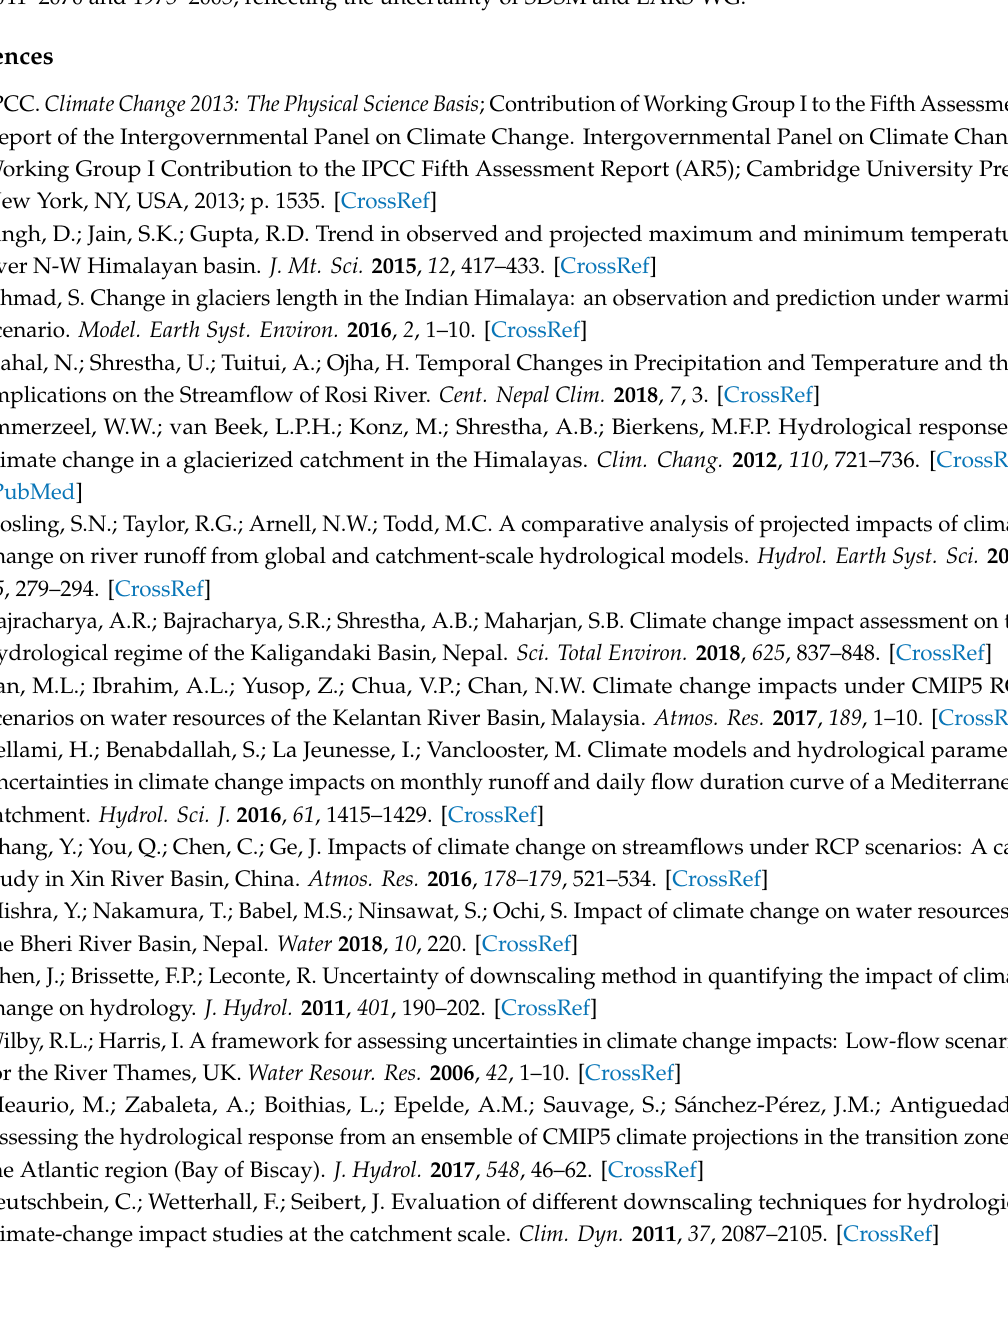
Figure A2. CDFs of annual changes in flow under ( a ) RCP4.5 and ( b ) RCP8.5 between the period 2041–2070 and 1975–2005, reflecting the uncertainty of SDSM and LARS-WG.